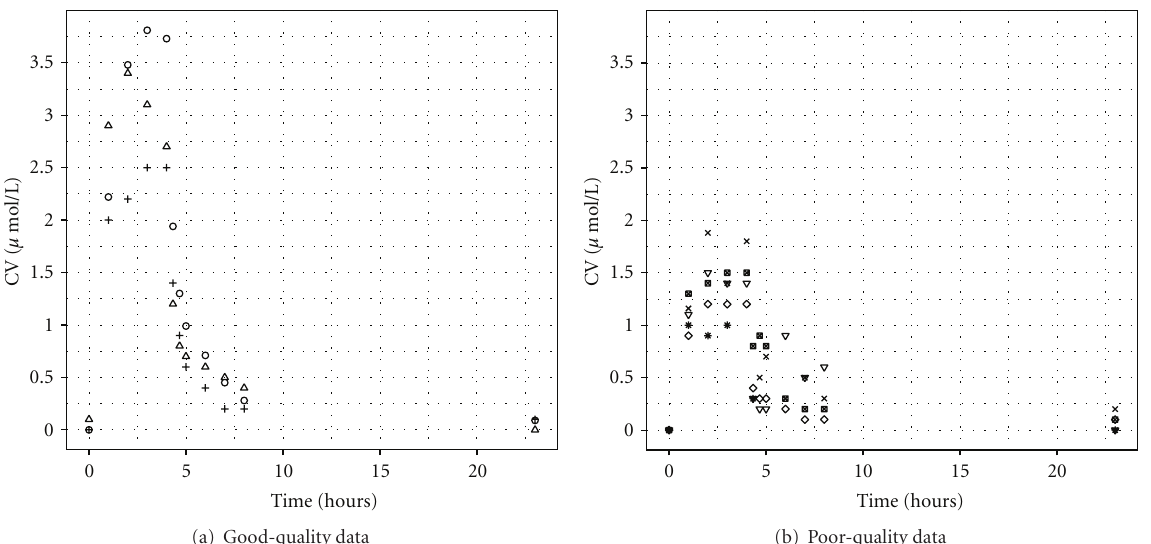
Figure 1: (a) Venous blood concentrations of m -xylene. Data from three volunteers were prepared and measured on a di ff erent day than other four. This set of data has the expected appearance and was considered acceptable for use in reverse dosimetry. (b) Venous blood concentrations of m -xylene. Data from four volunteers were prepared and measured on a di ff erent day than other three. This set of data does not have the expected appearance and was considered unacceptable for use in reverse dosimetry.